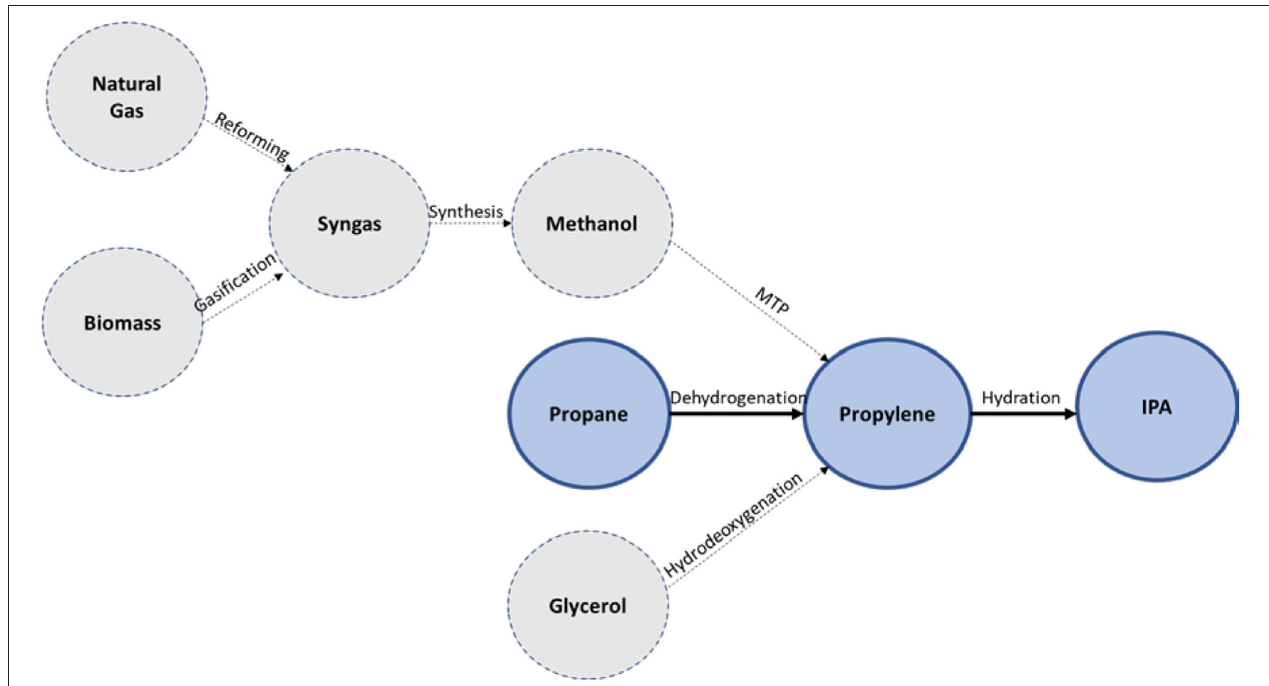
FIGURE 10 | Alternate pathways for mitigating disruption or insufficiency in propane feedstock to produce isopropyl alcohol (adapted from Panjapakkul and El-Halwagi, 2018 ).